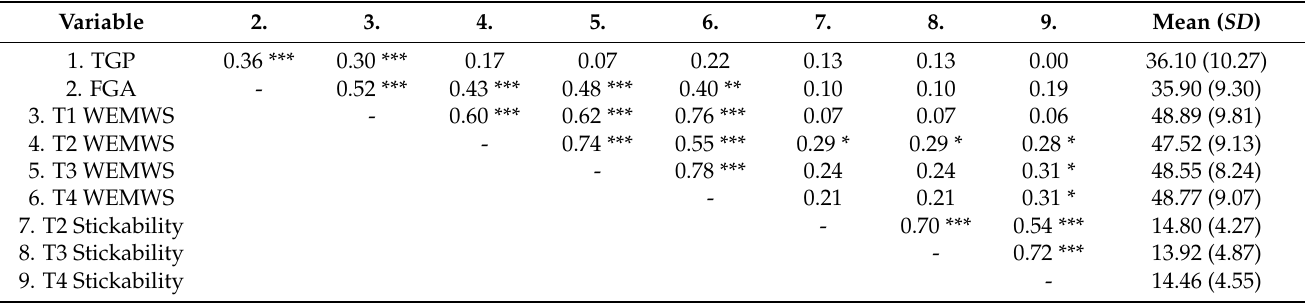
Table 1. Descriptive statistics and Pearson’s r correlation between study